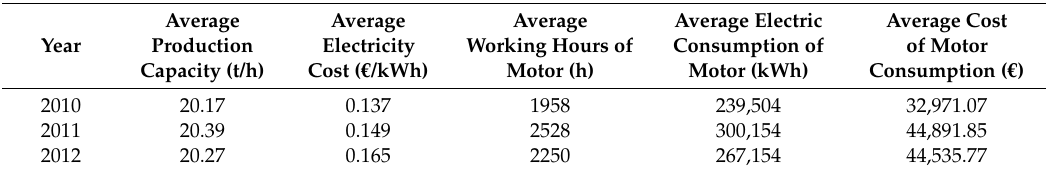
Table 4. Operation costs of the motor.